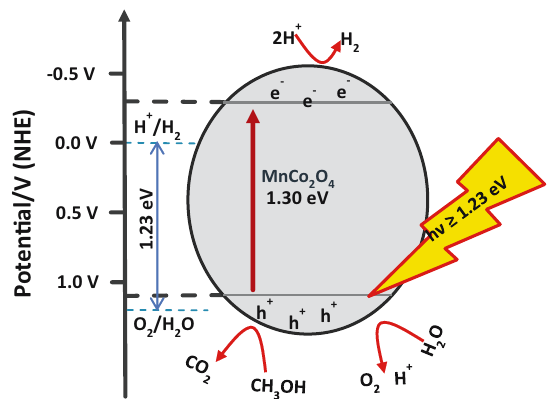
Figure 9: Schematic of the photogenerated charge carriers of the MCOs for the visible - light photocatalytic H 2 production from H 2 O.